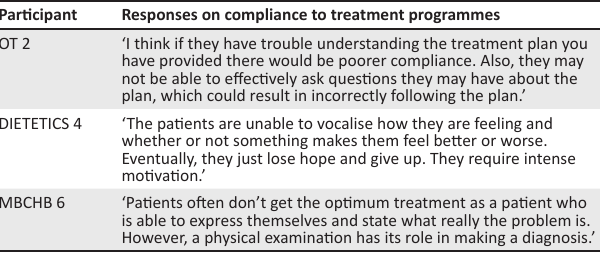
TABLE 5: Participants’ responses on the effect of communication disorders on patient compliance to treatment programmes. Participant Responses on compliance to treatment programmes OT 2